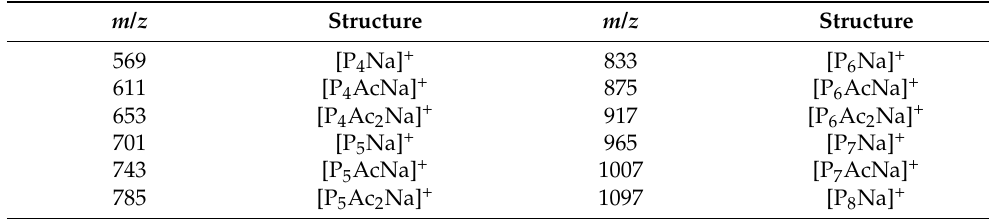
Table 2. Structural assignment of the mass signals obtained by MALDI-TOF-MS. m / z Structure m / z Structure 569 [P 4 Na] + 833 [P 6 Na] + 611 [P 4 AcNa] + 875 [P 6 AcNa] + 653 [P 4 Ac 2 Na]